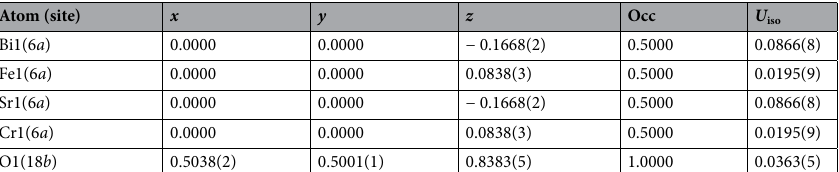
Table 1. Refined structural parameters of Bi 0.5 Sr 0.5 Fe 0.5 Cr 0.5 O 3 from powder diffraction data collected at room temperature. SP: R 3 c , a = 5.5726(22) Å , b = 5.5726(22) Å , c = 13.6500(64) Å , Chi 2 = 1.877, R wp = 5.97%, R p =